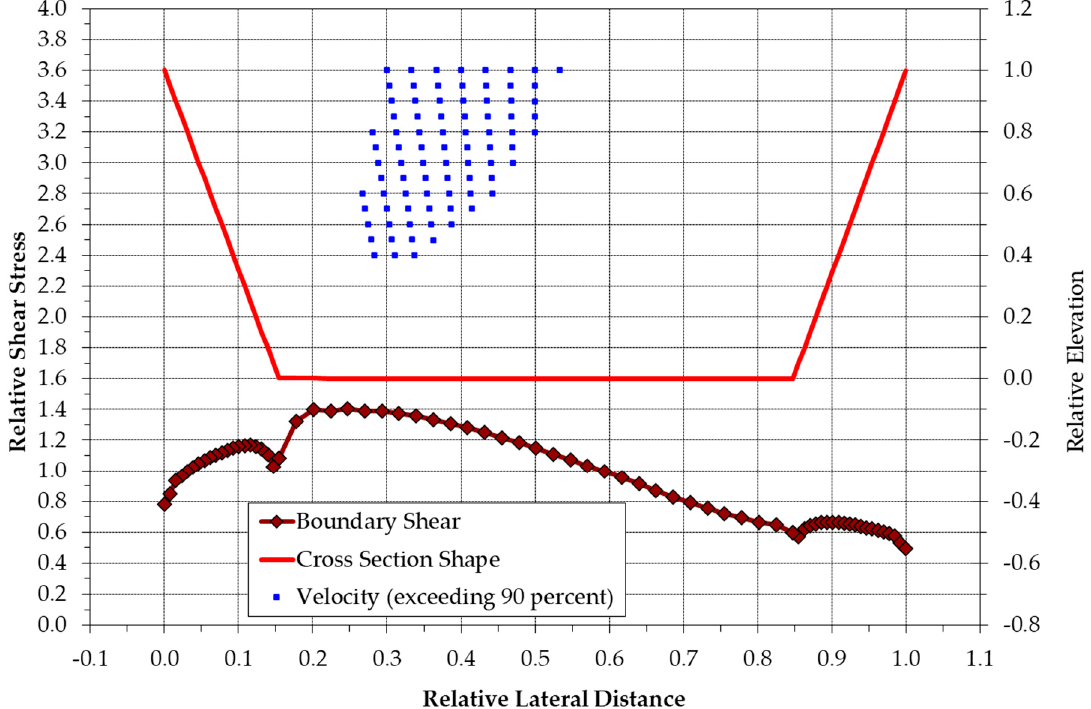
Figure 36. Cross-section 950 (3rd meander bend) lateral distribution of shear stress and zone where velocity is at least 90 percent of the maximum velocity.